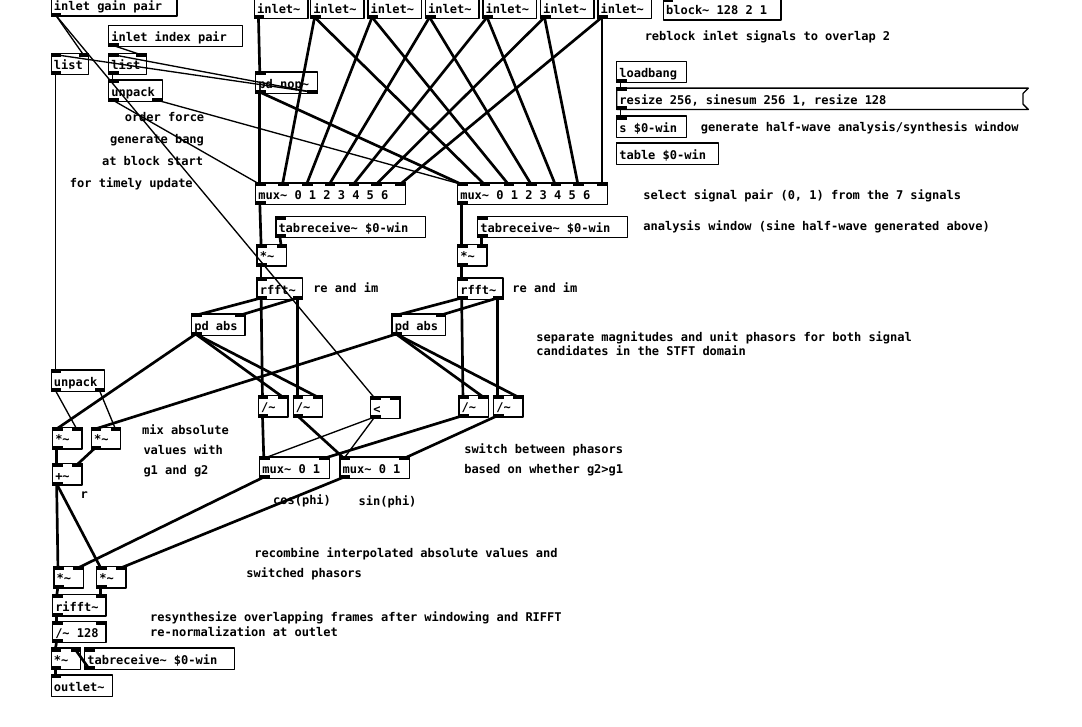
$0-winreblock inlet signals to overlap 2 loadbang